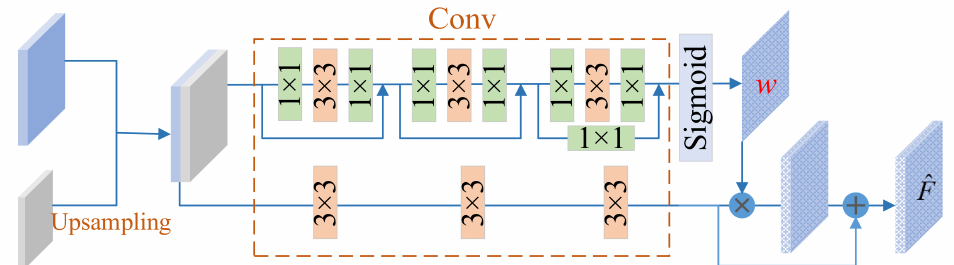
Figure 2. Attention mechanism (AM). The features of adjacent layers are first up-sampled to the same size, and are then passed through a series of convolution operations to obtain the attention weight map, w , and the refined features, ˆ F